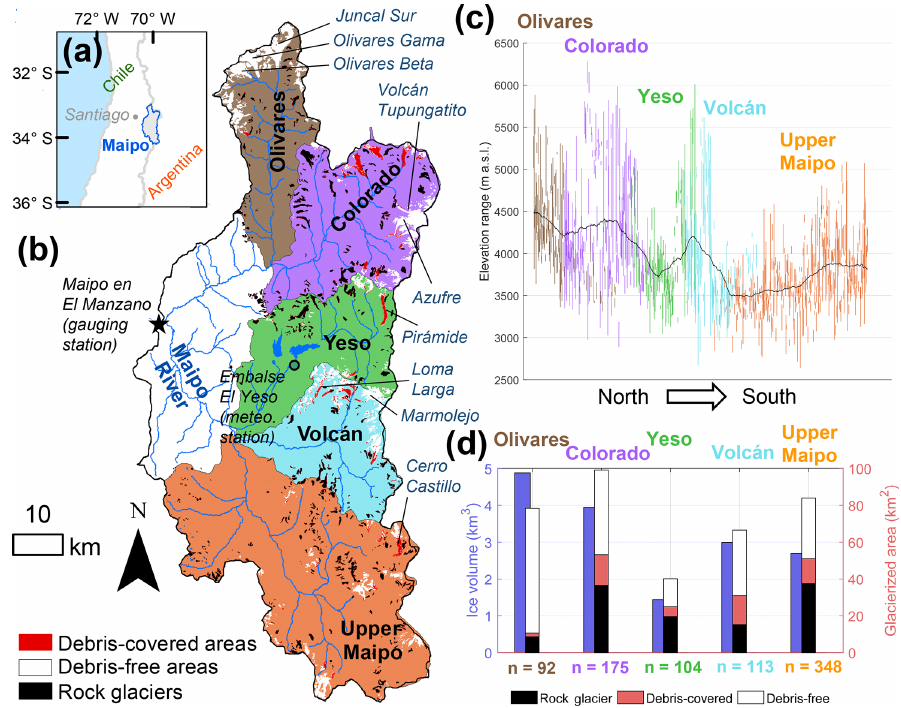
Figure 1. (a) Maipo River basin, next to the city of Santiago in central Chile. (b) The basin outlet and the sub-catchments, rivers, main glaciers, and hydrometeorological stations. (c) The elevation range of every glacier in the basin as a function of the average latitude (arbitrary scale) in each sub-catchment and the mean elevation (black line). (d) Estimated total ice volume using the method developed by Huss and Farinotti (2012) (left axis) and glacierized area (right axis) in each sub-catchment. The surface and glacier type (debris-free, debris-covered, or rock glacier) and the number of glaciers in each sub-catchment are